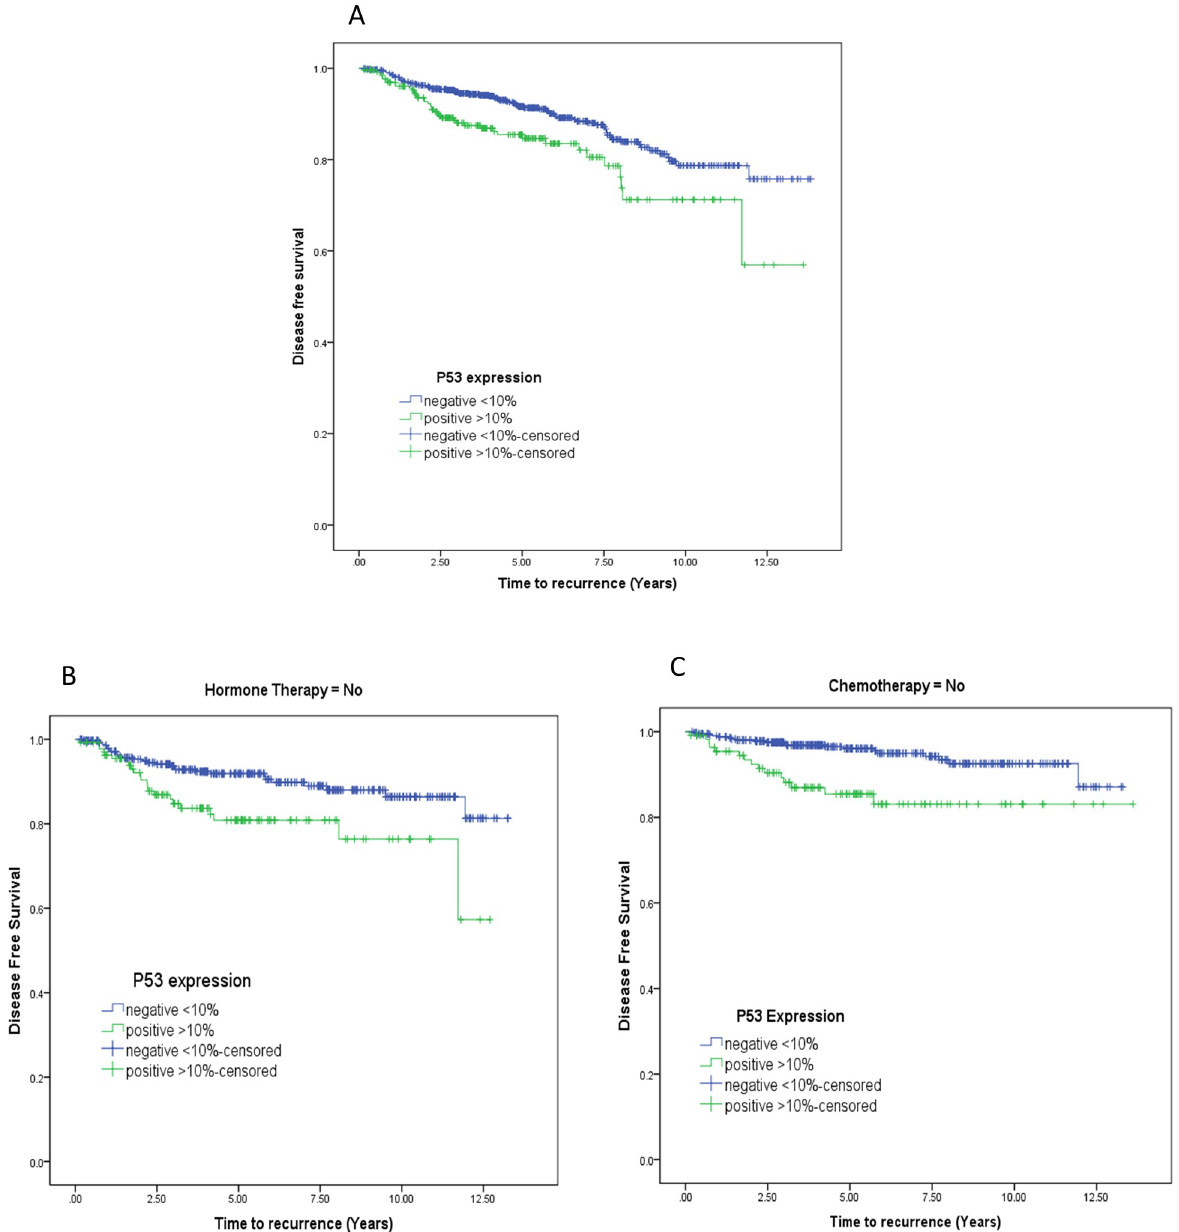
Fig 2. Survival probability based on P53 marker. A : Disease free survival probability (Kaplan-Meier curve, negative vs. positive, p = 0.002) B : Disease-free survival for hormone therapy (P = 0.005). C : Disease-free survival for chemotherapy (p < 0.0001).